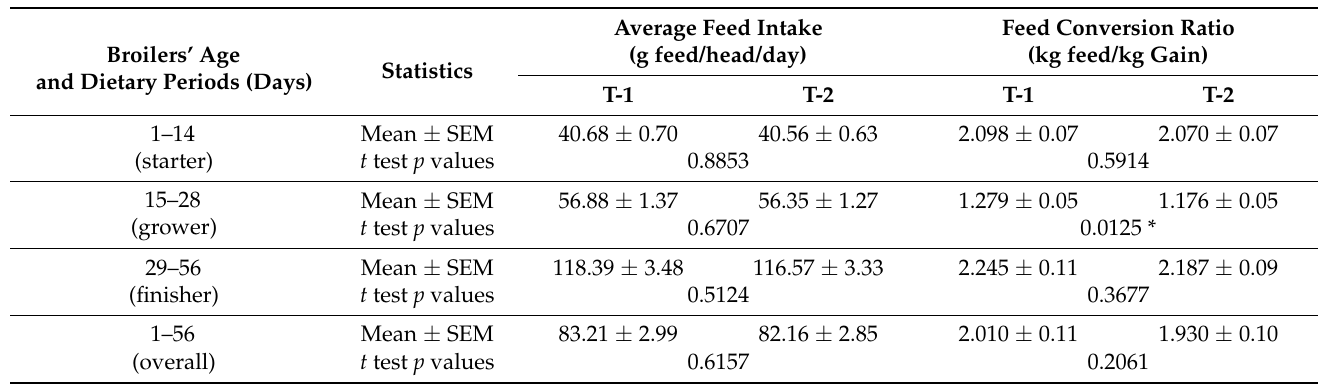
Table 4. Feed intake and feed conversion rates.